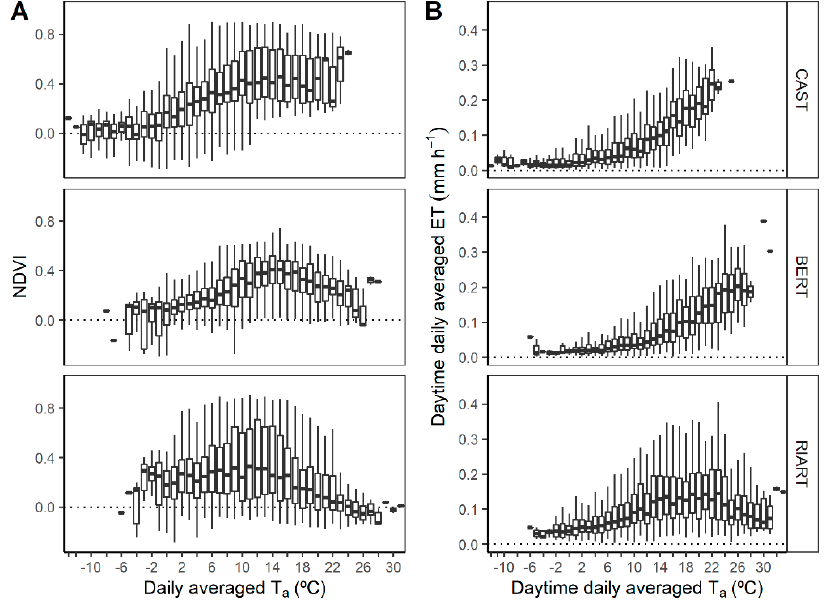
Figure 8. Daily averaged ( A ) normalized vegetation index (NDVI) as function of ambient temperature